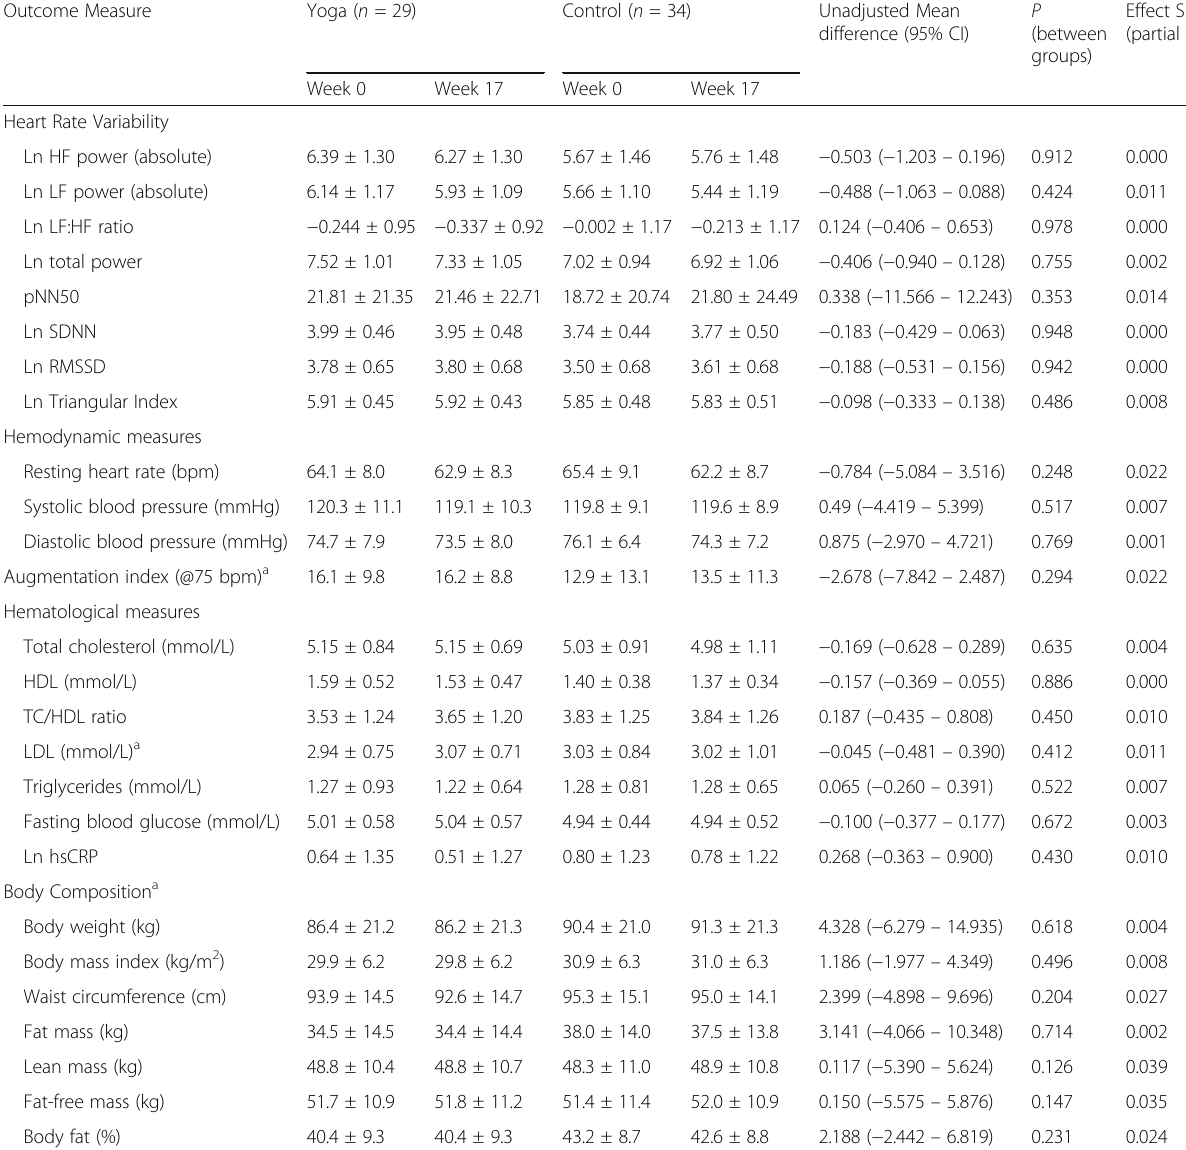
Table 2 Summary of between group changes on clinical outcomes Outcome Measure Yoga ( n = 29) Control ( n = 34) Unadjusted Mean